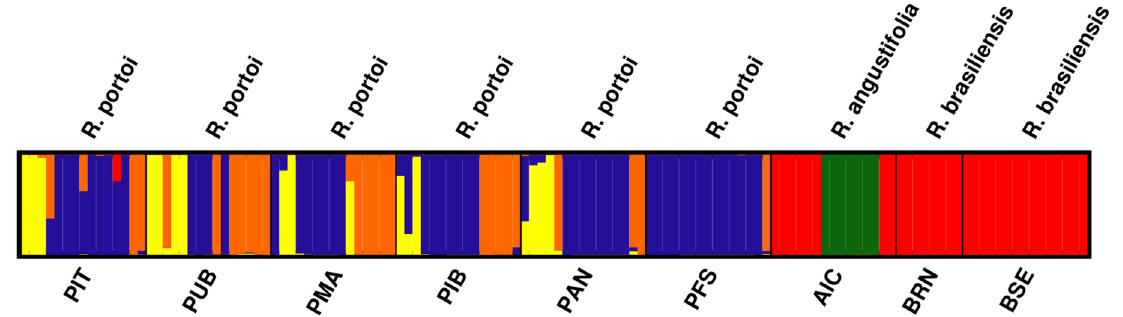
Figure 3. Graphic representations of the structure of the populations of Raddia created based on 20 runs of STRUCTURE with ISSR data, choosing K = 2 ( a ) and K = 5 ( b ). Different colors represent different gene pools, and each vertical bar represents an individual. For population codes, see the sampling subitem on material and methods.